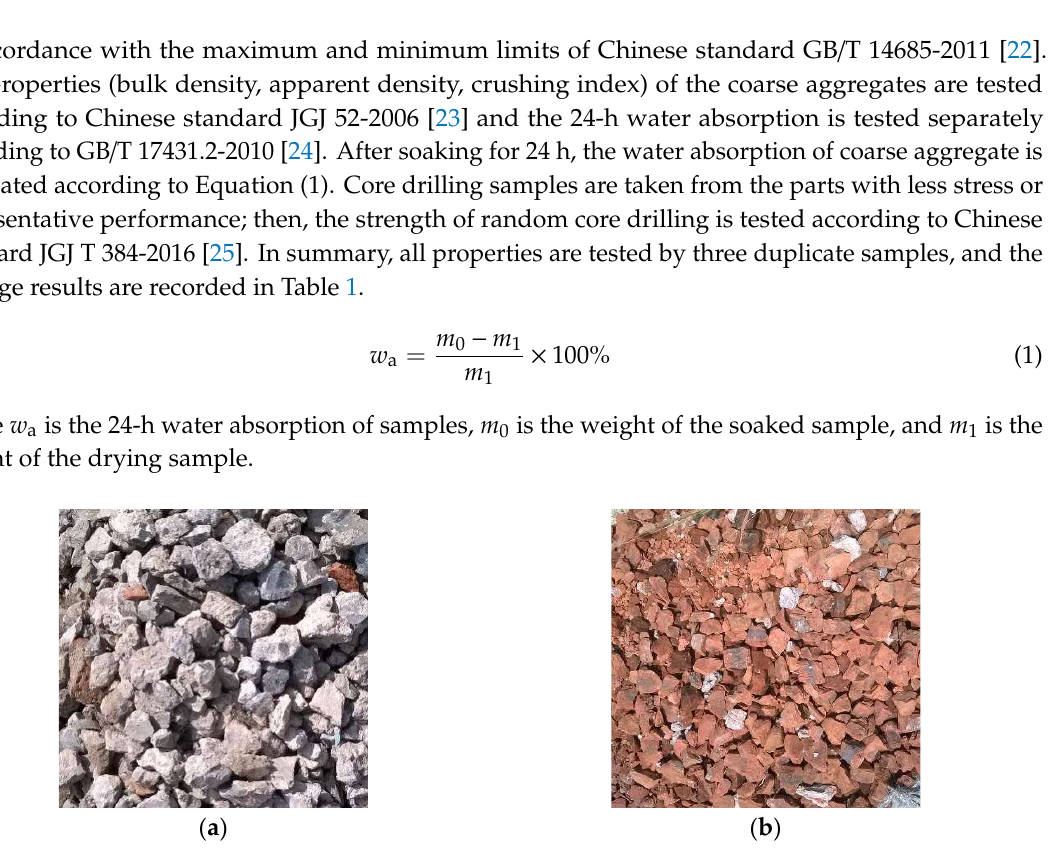
Figure 1. Recycled aggregates: ( a ) recycled concrete aggregate (RCA); ( b ) recycled brick aggregate (RBA).